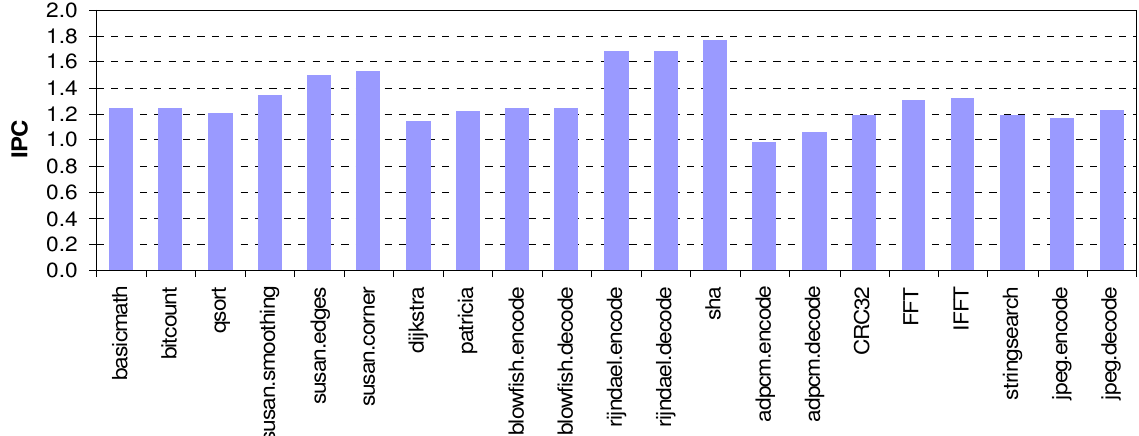
Figure 1. IPC performance of an ideal dual issue embedded